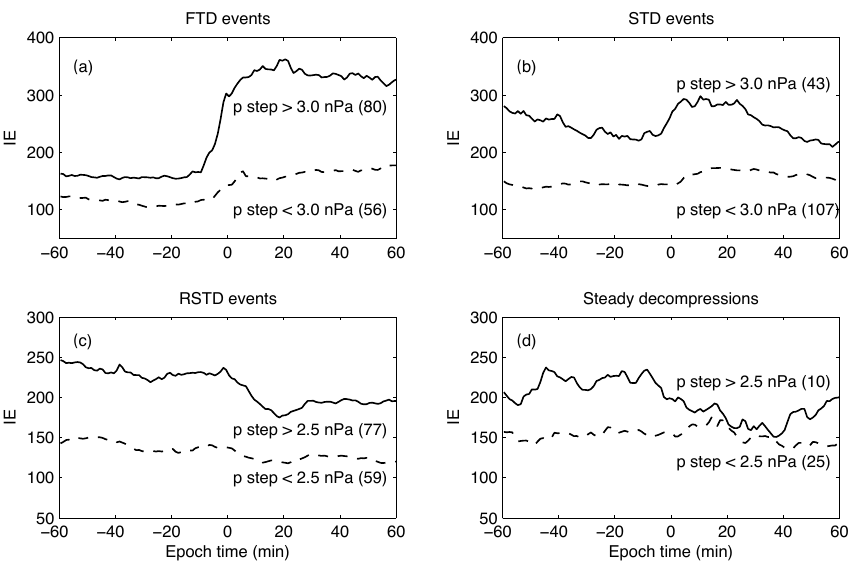
Fig. 6. Ionospheric response according to the dynamic pressure step size. Solid (dashed) lines show events for which the dynamic pressure step has been larger (smaller) than a threshold value given in each panel. Superposed epoch averages for the IE index for (a) FTD (b) STD, (c) RSTD and (d) steady decompressions are shown. Numbers in parentheses near each line show the amount of events in each category.